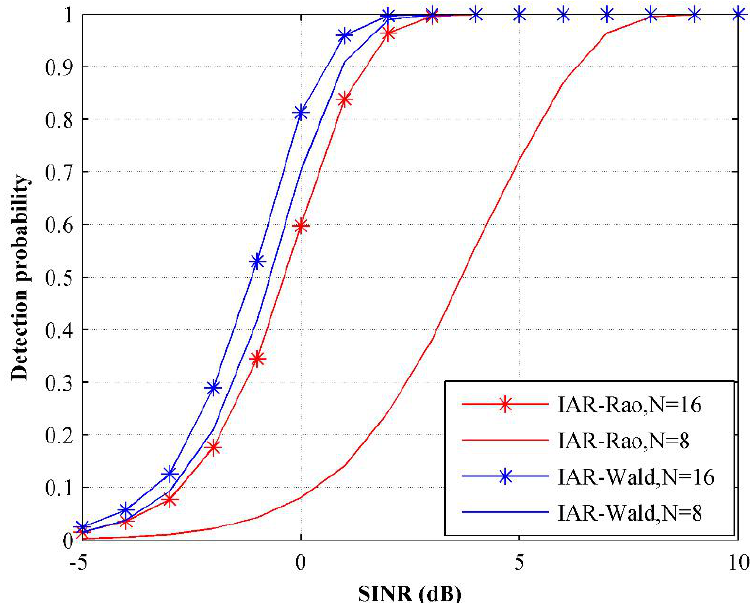
Figure 7. P d versus SINR for P fa = 10 − 4 , L = 80, K = 0 and various N .